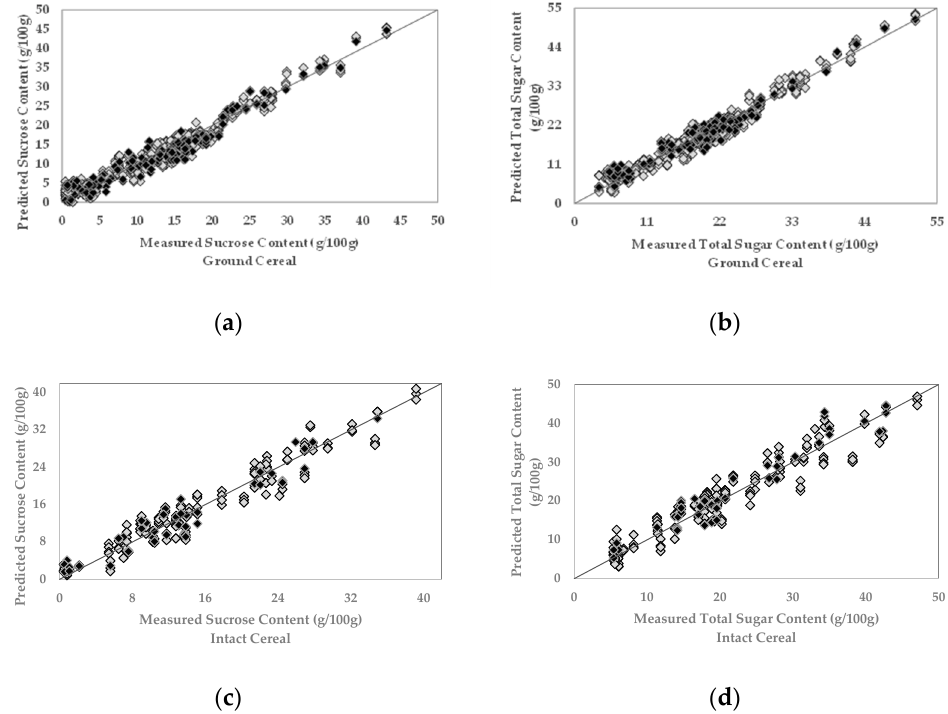
Figure 3. Partial least square regression (PLSR) plots for sucrose ( a , c ) and total sugar ( b , d ) content in ground and intact breakfast cereal samples. The gray diamonds represent the calibration set samples; the black diamonds represent the external validation set samples.